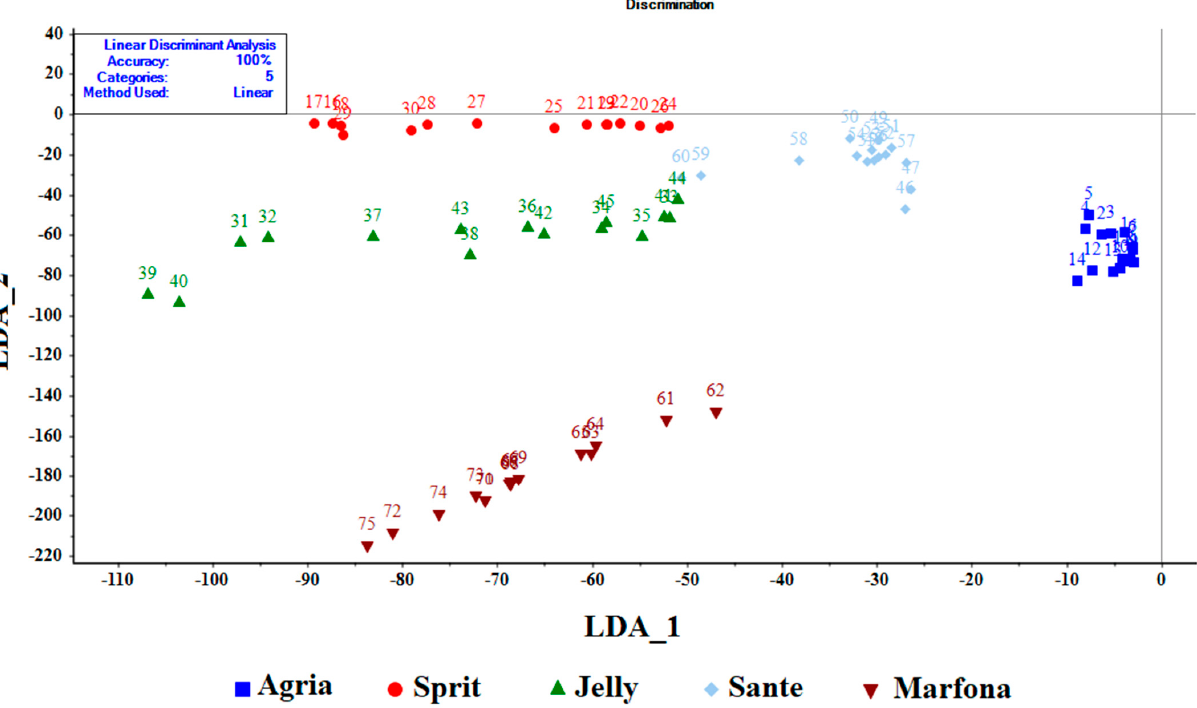
Figure 7. LDA analysis to identify five different potato cultivars.